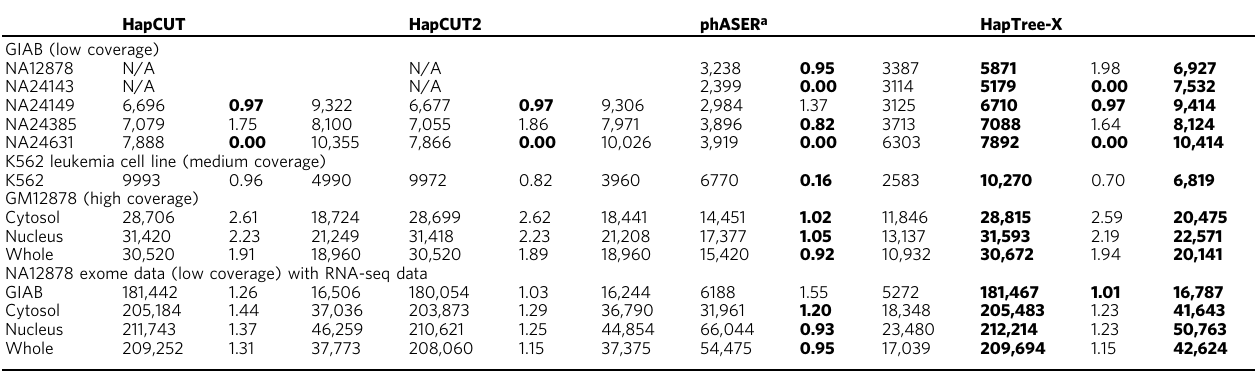
Table 1 Comparison of phasing quality for four different phasers: HapCUT, HapCUT2, phASER, and HapTree-X on 9 RNA-seq datasets with varying transcriptomic coverage and on four different RNA-seq datasets combined with the NA12878 exome